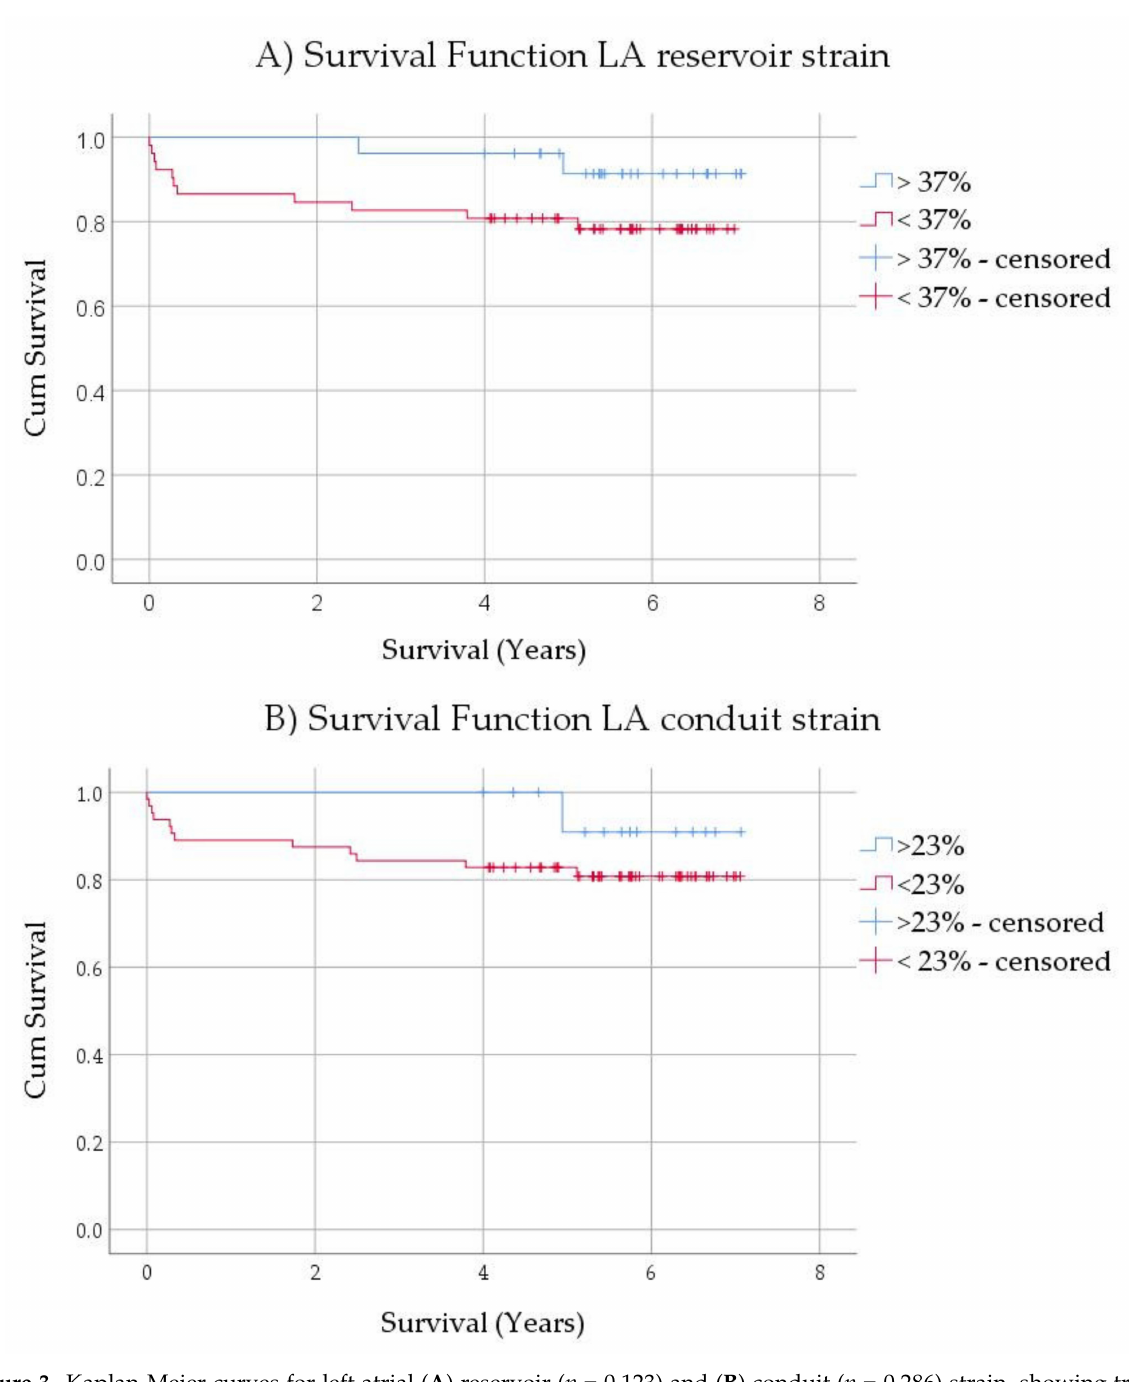
Figure 3. Kaplan-Meier curves for left atrial ( A ) reservoir ( p = 0.123) and ( B ) conduit ( p = 0.286) strain, showing trend towards increased post-transplant mortality. LA: left